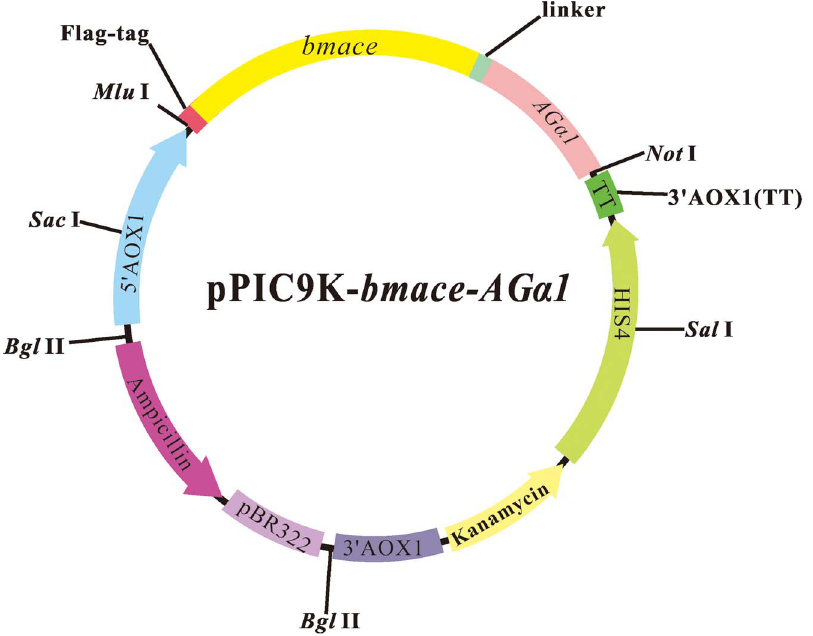
Figure 2. Construction of the Bm AChE-display with the P.pastoris expression system based on a -agglutinin. The bmace and AG a 1 DNA segments were spliced using overlap extension PCR to assemble the bmace-AG a 1 gene and inserted into pPIC9K for the pPIC9K- bmace-AG a 1 construction.